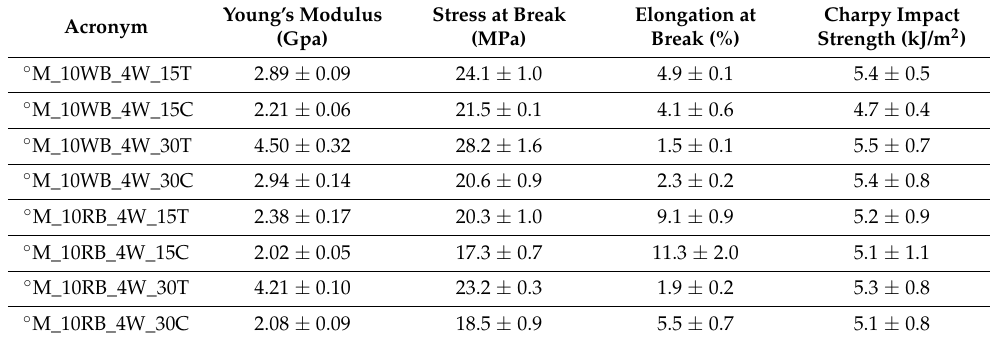
Table 3. Quasi-static mechanical properties and impact behavior of bio-composites with inorganic